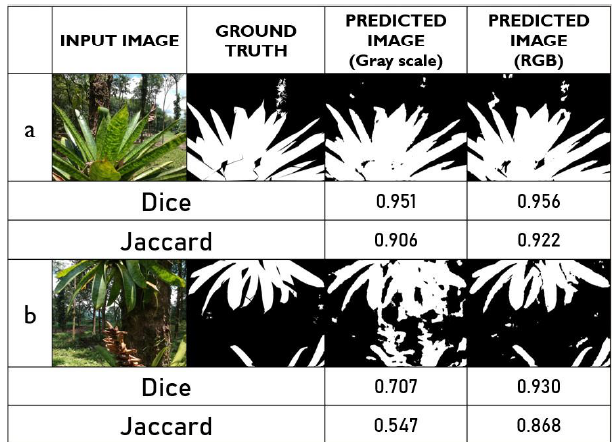
Table 1: Parameter settings for training DRU-Net (Jafari et al.,